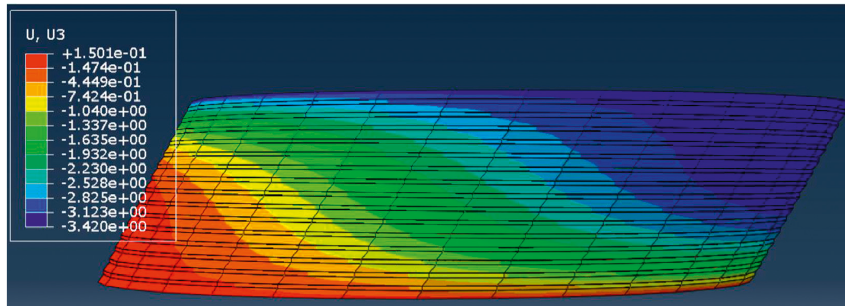
Figure 22: Vertical displacement cloud of the bearing when the horizontal displacement is 75mm.